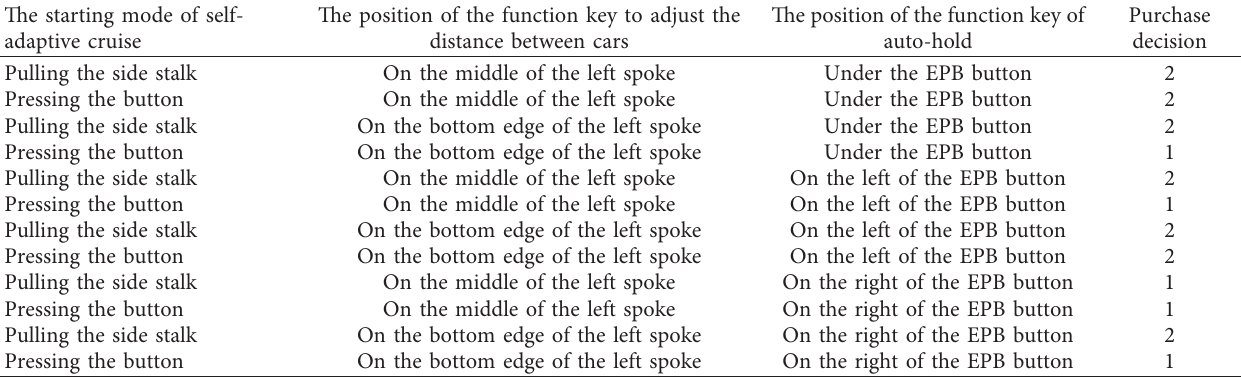
Table 2: Classification of purchase intentions to interaction modes.